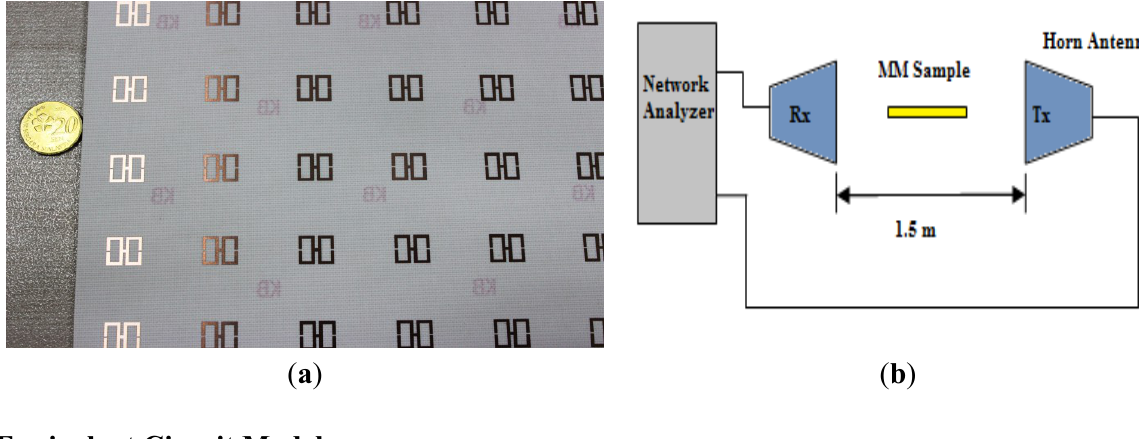
Figure 2. ( a ) The prototype array of the H-shaped structure; ( b ) experimental